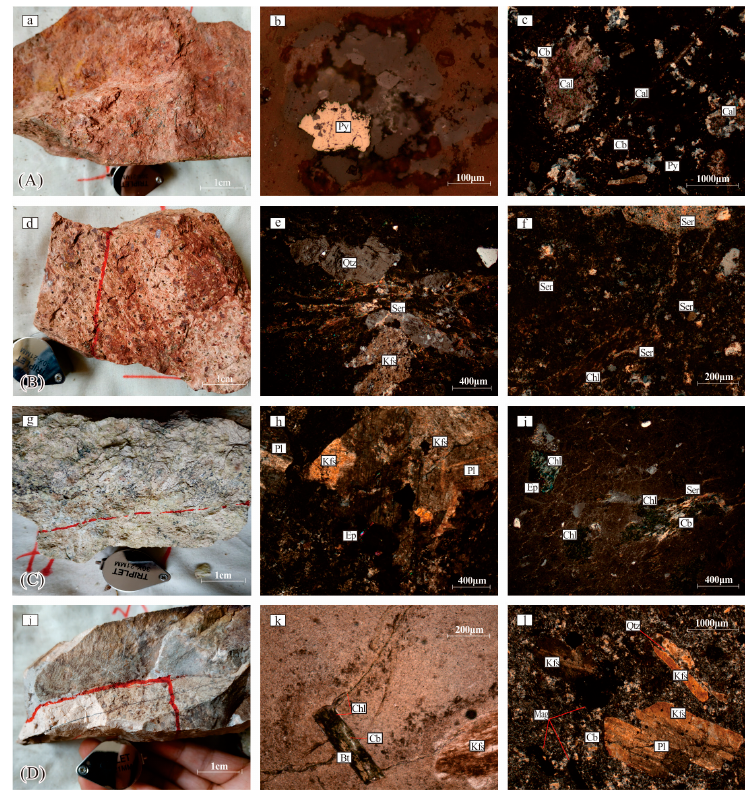
Figure 4. Rock characteristics of four alteration zones: ( A ) mineralization center; the most strongly altered sample of ore from the Zhangjiawu uranium deposit. The ore is red in color and relatively fragmented ( a ), with strong hematite, chlorite, carbonate and clay mineralization, and fine-grained pyrite can be seen in the margins suffering from dissolution; potassium feldspar has undergone strong modification and has an earthy surface ( b , c ); ( B ) adjacent alteration zone: the rock is reddish in color ( d ), with strong sericitization, chloritization and clayification, and strong hematite mineralization in places ( e , f ); ( C ) near alteration zone: the rocks are grayish-white-light green ( g ), with strong chloritization, sericitization, sodic feldspar and carbonatization, and chloritization of black mica is visible ( h , i ); ( D ) far alteration zone: the rocks are light red ( j ), with mainly sodic feldsparization, chloritization of black mica, carbonatization and strong mudification of potassium feldspar ( k , l